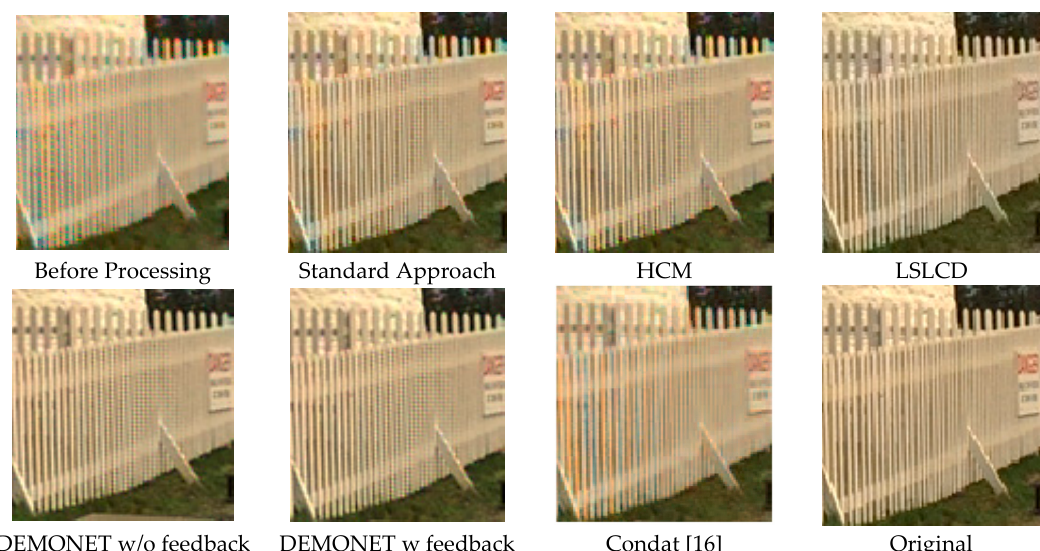
Figure 14. Averaged CIELAB values of different methods.